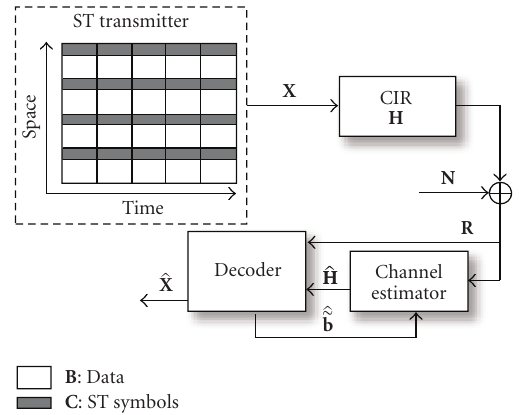
B : Data C : ST symbols Figure 2: MIMO digital communication system